Question: Name the type of graph shown.
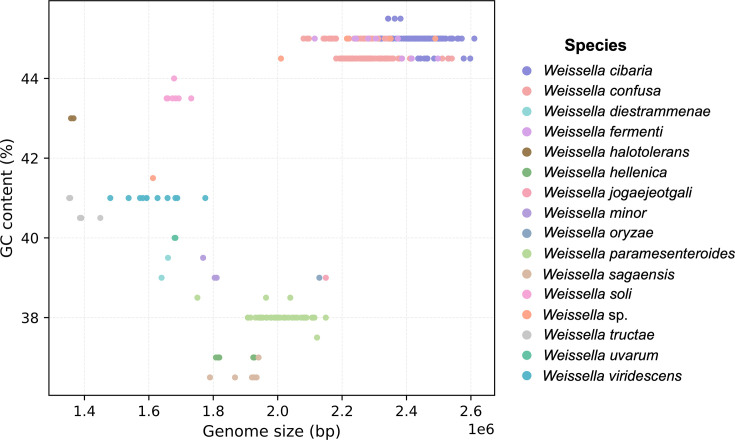
Answer: scatter